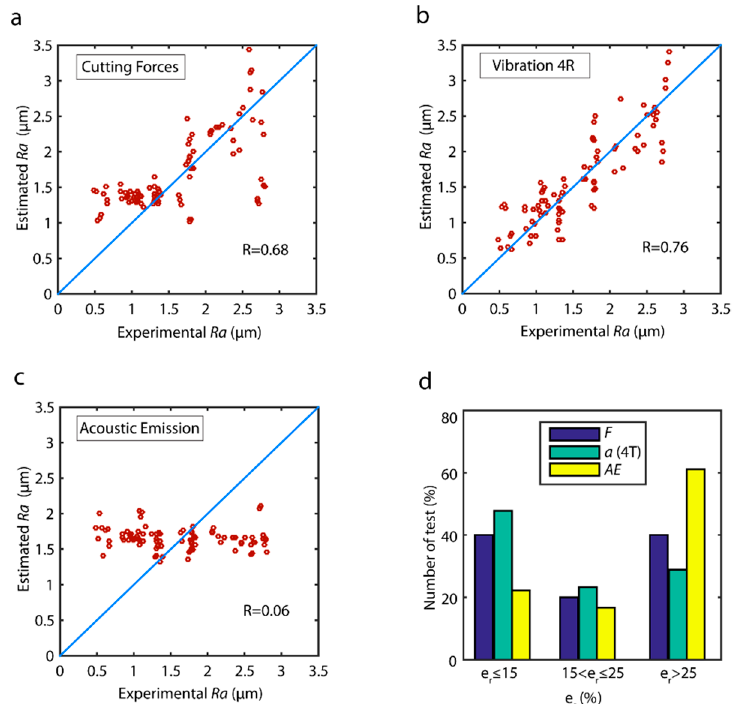
Figure 8. Estimated values versus experimental validation values of the parameter Ra for the PSD method: ( a ) cutting forces, ( b ) vibration (4R), and ( c ) acoustic emission. ( d ) Prediction reliability with the PSD method.